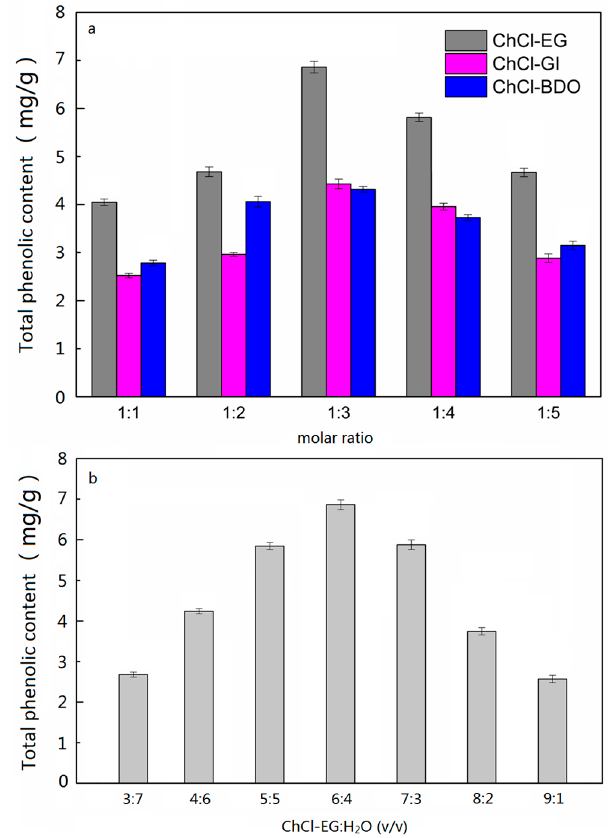
Figure 2. Screening of deep eutectic solvent (DES), including composition of DES ( a ) and amount of water added to DES ( b ).